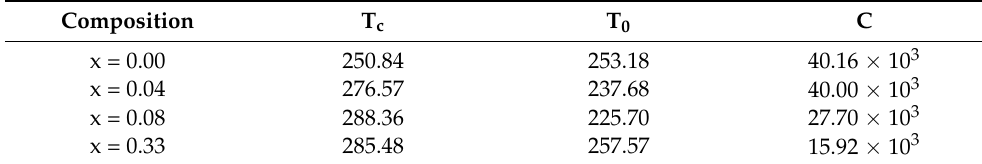
Table 6. Curie–Weiss parameters for the investigated solid solution. Composition T c T 0 C x = 0.00 250.84 253.18 x = 0.04 x =